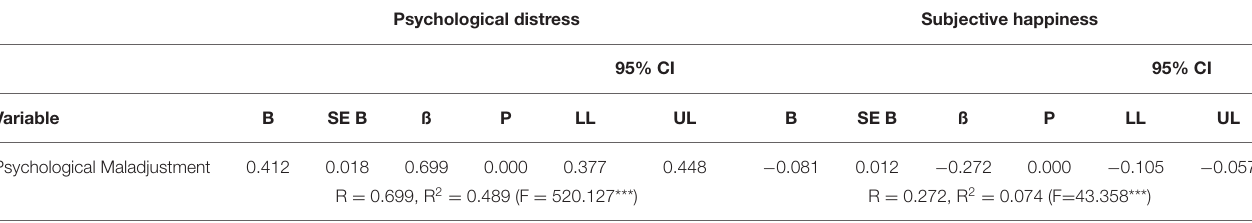
TABLE 5 | Regression coefficients of psychological maladjustment on psychological distress and